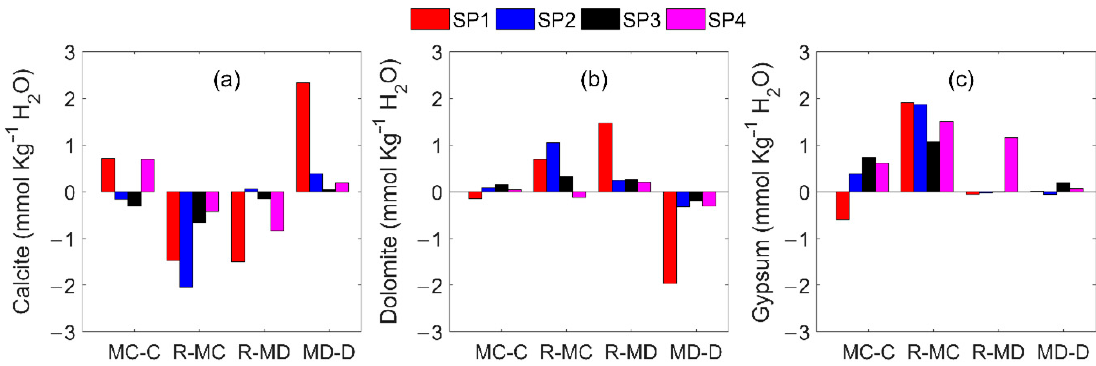
Figure 6. Dissolution/precipitation rates of Calcite ( a ), Dolomite ( b ), and Gypsum ( c ) in the RC. Positive values indicate dissolution and negative values indicate mineral precipitation.